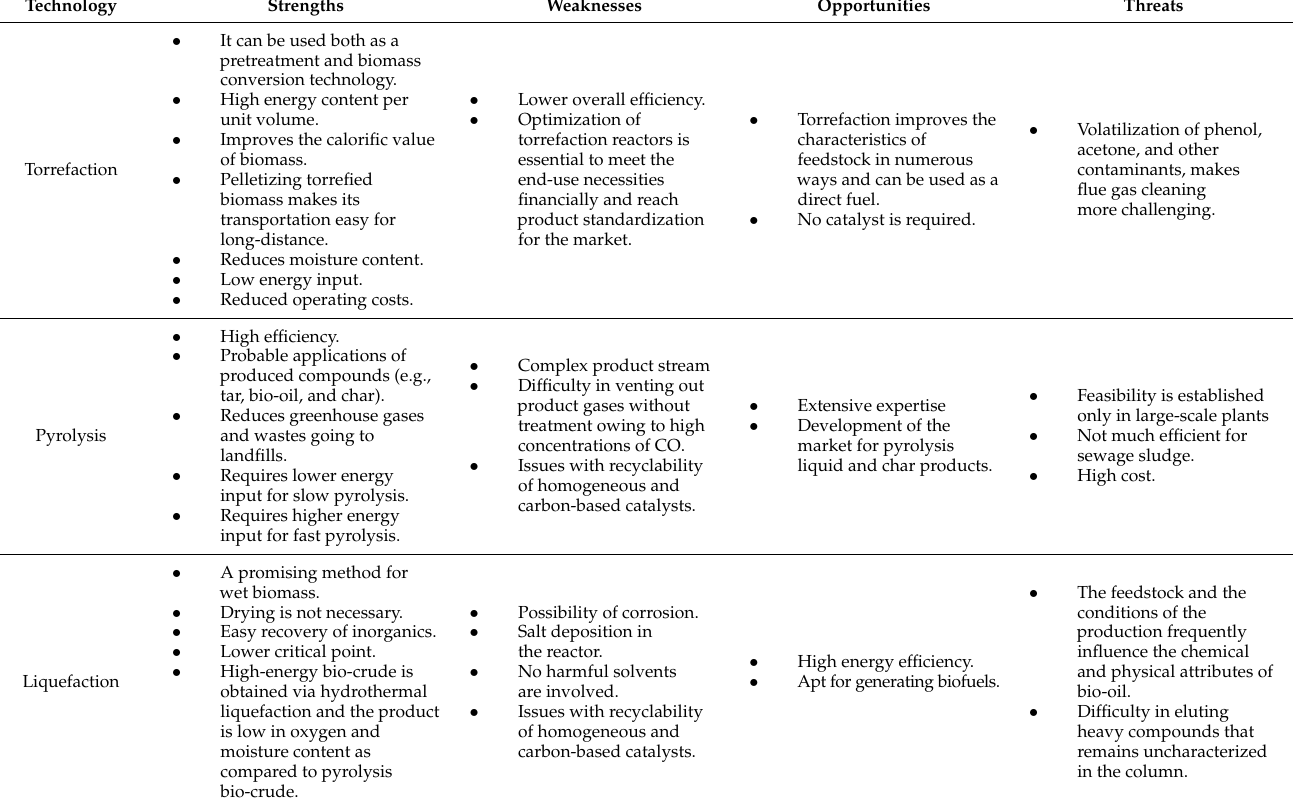
Table 7. Summary of strengths, weaknesses, opportunities and threats of thermochemical biomass conversion